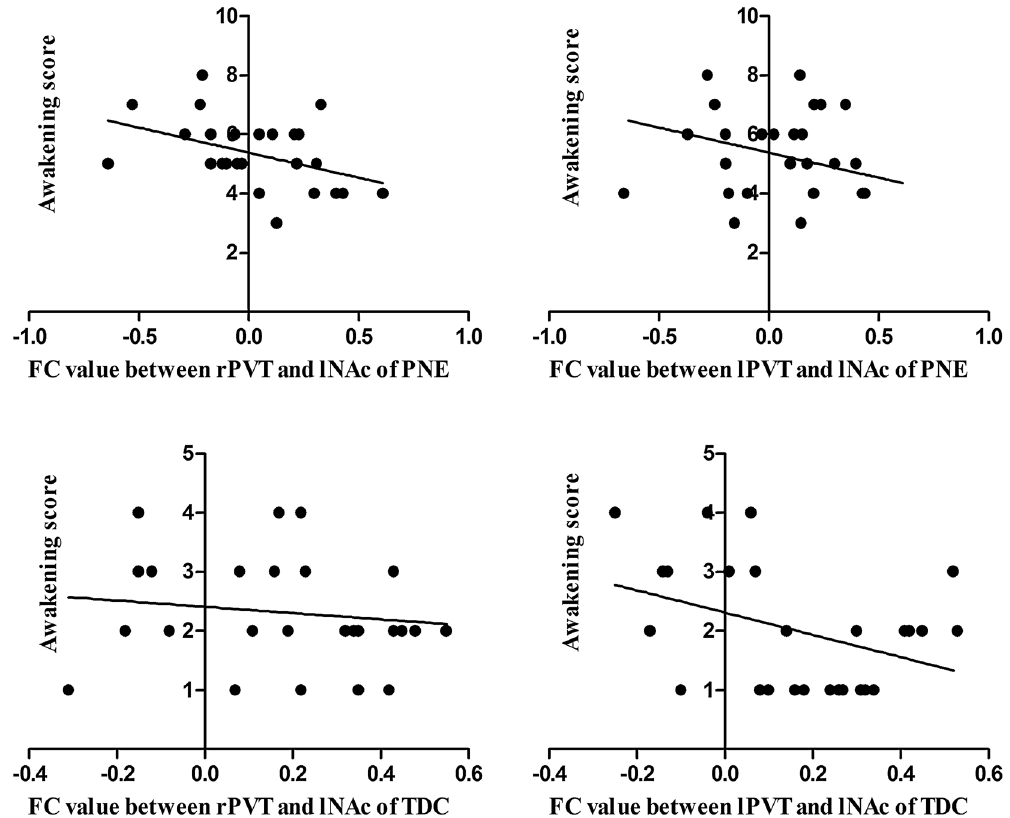
Figure 3. The correlation of the FC value between lNAc and bilateral PVT and awakening score of PNE and TD